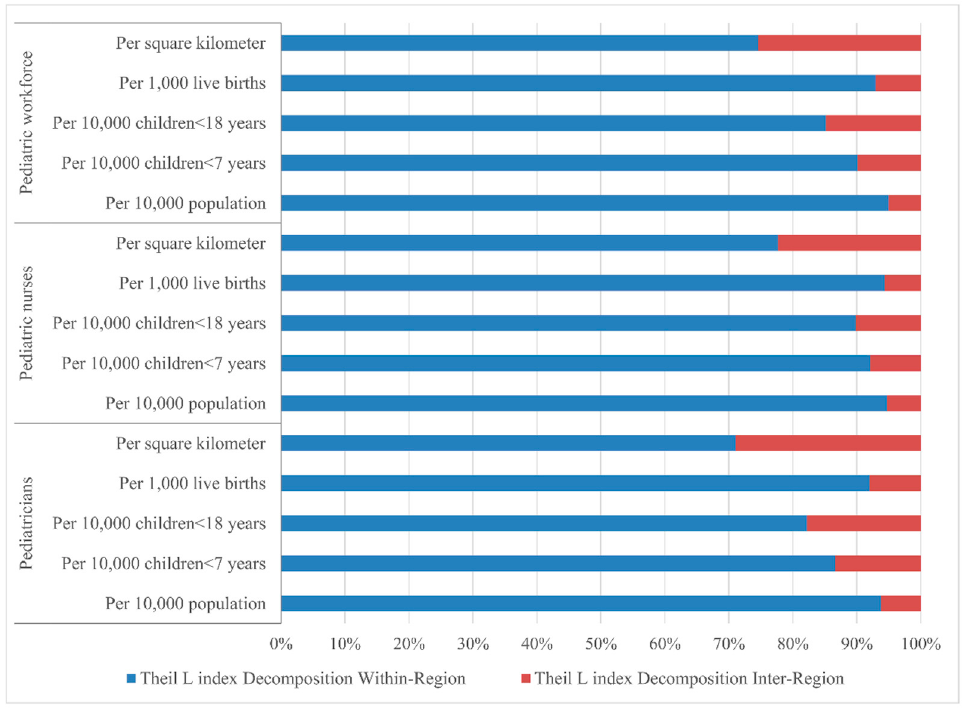
Figure 4. Comparison of Theil L indexes of different indicators at both national and regional levels.